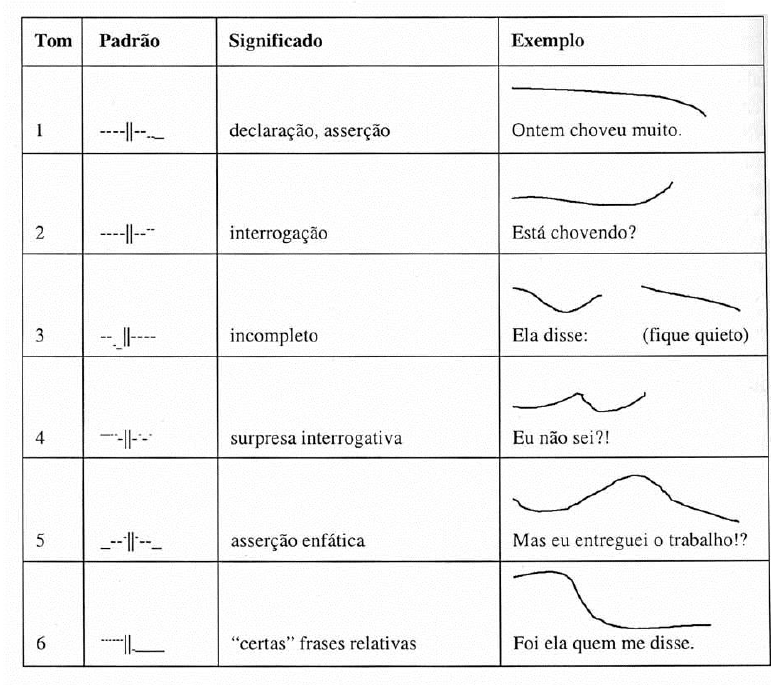
Figure 1. Classification of intonation contours in Cagliari (1981), reproduced from Massini-Cagliari and Cagliari